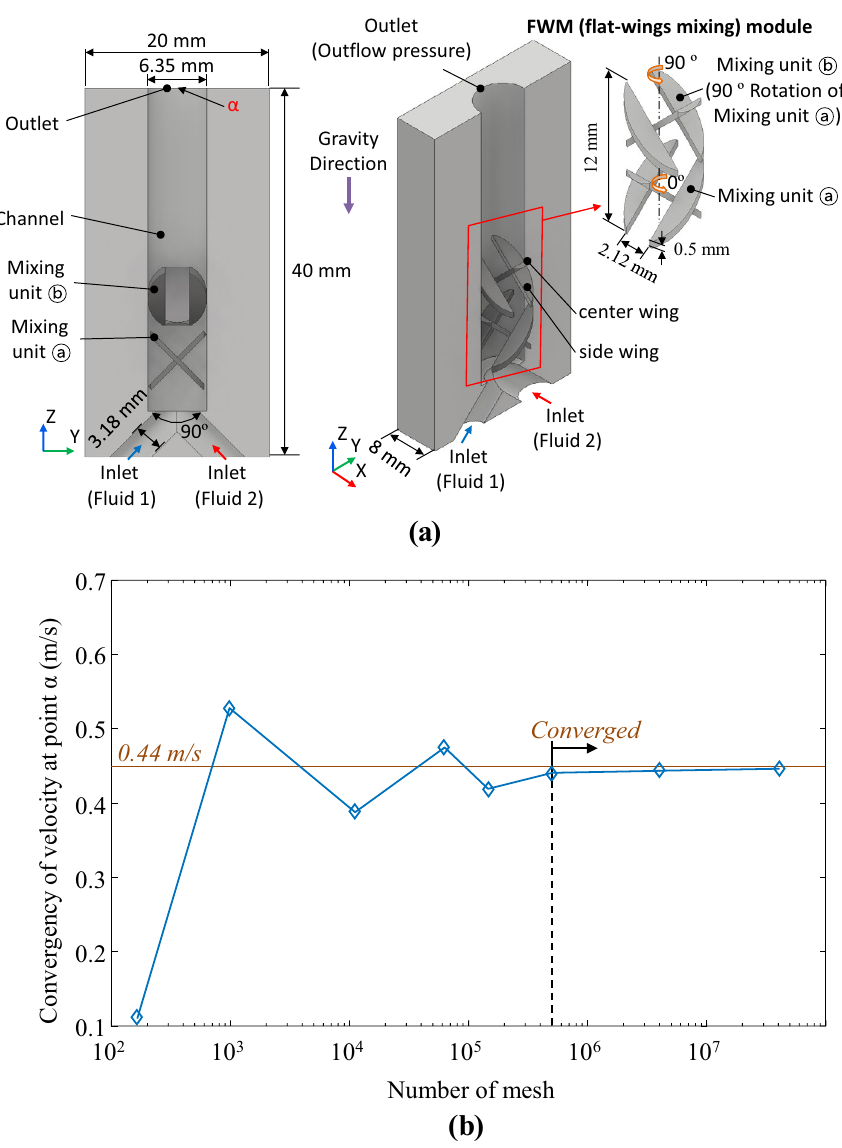
Figure 1. Analysis condition of mixing. ( a ) Boundary conditions and geometries of the mixing analysis. The basic analysis model consisted of two inlets (each diameter of 3.18 mm) and 1 outlet (diameter of 6.25 mm) with a flat-wings mixing module (FWM module) placed and ( b ) results of mesh convergency according to various mesh condition at point α shown in ( a ); convergence condition is the mesh number of more than 5 × 10 5